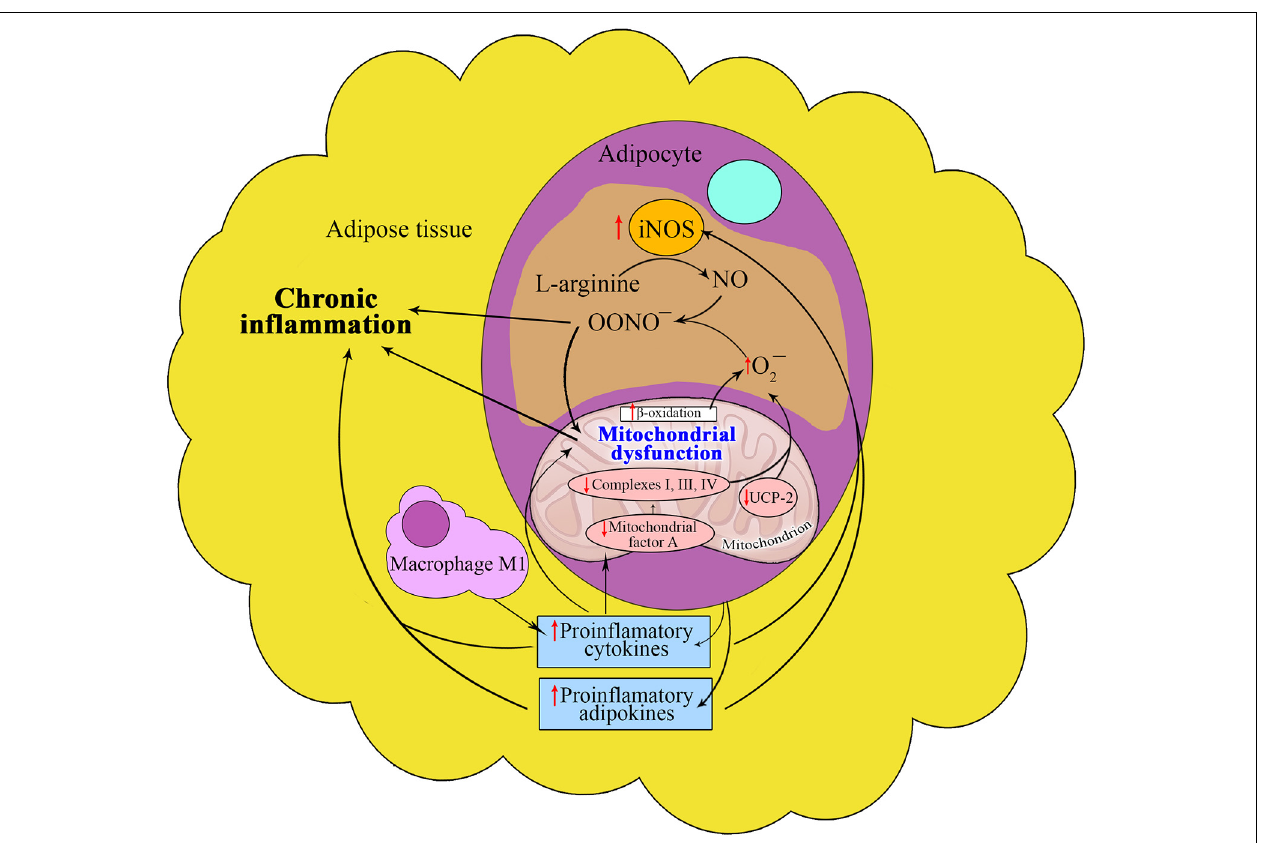
FIGURE 2 | Interrelation between nitric oxide and mitochondria in adipose tissue in metabolic syndrome. The proinflammatory microenvironment of adipose tissue induces the iNOS activity in MS that increases peroxynitrite synthesis, thus contributing to oxidative stress and chronic inflammation. Under the influence of these